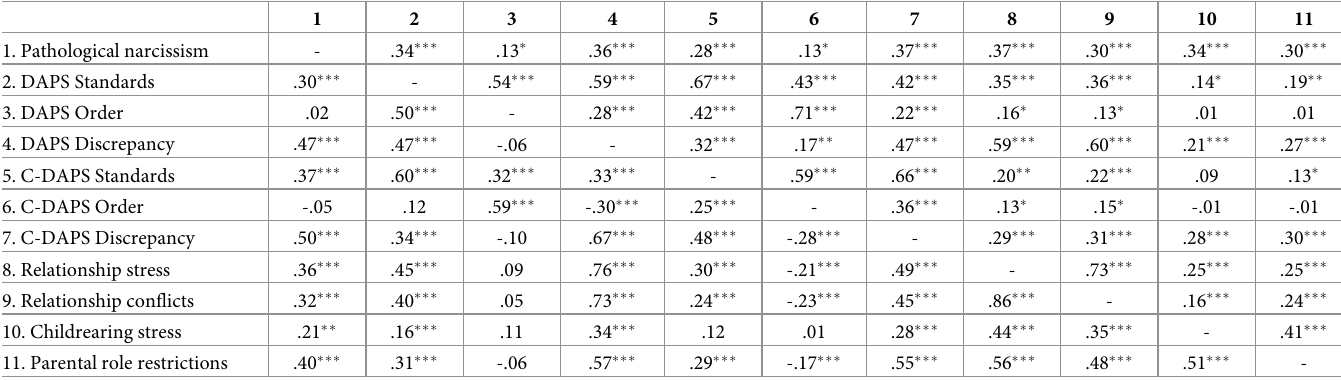
Table 2. Correlations between the analyzed variables in women and